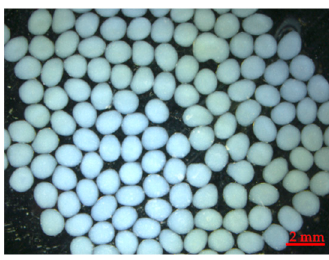
Figure 3. The encapsulation of crude dextranase from Penicillium roquefortii TISTR 3511 in alginate beads.